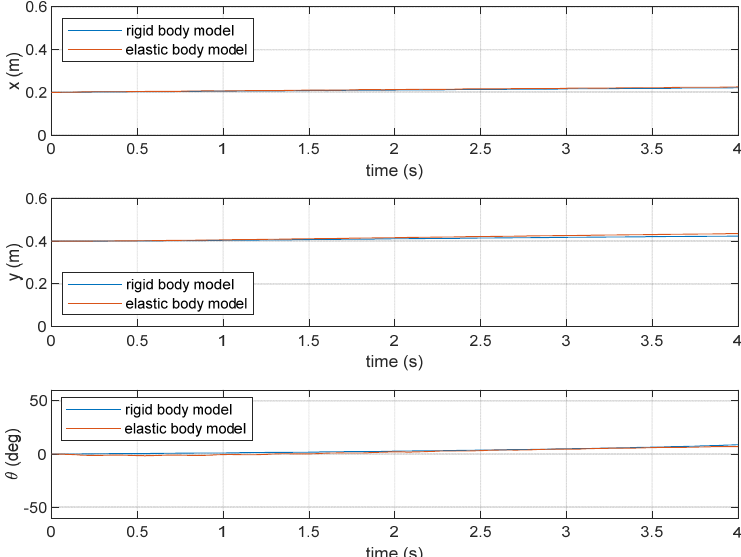
Figure 9. End-effector position obtained by using rigid body and flexible body models based on finite element method in the case of sinusoidal loading.